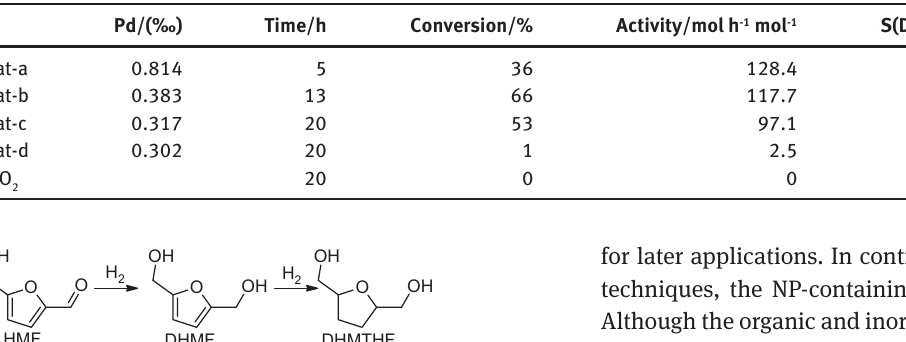
for the hydrogenation of HMF. 2